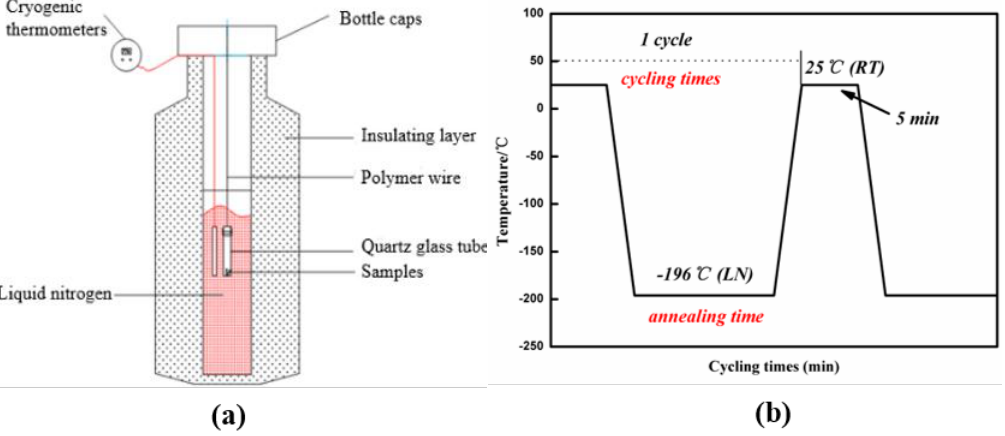
Figure 1. ( a ) Schematic of the experimental device and ( b ) the thermal cycling process diagram, where the red phrases are the experimental variables. (For details of the thermal parameters, see Table S1.)